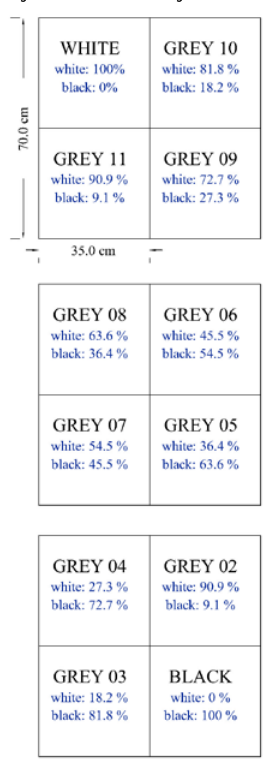
Figure 3. The project of the segment no 2: 12- level grayscale